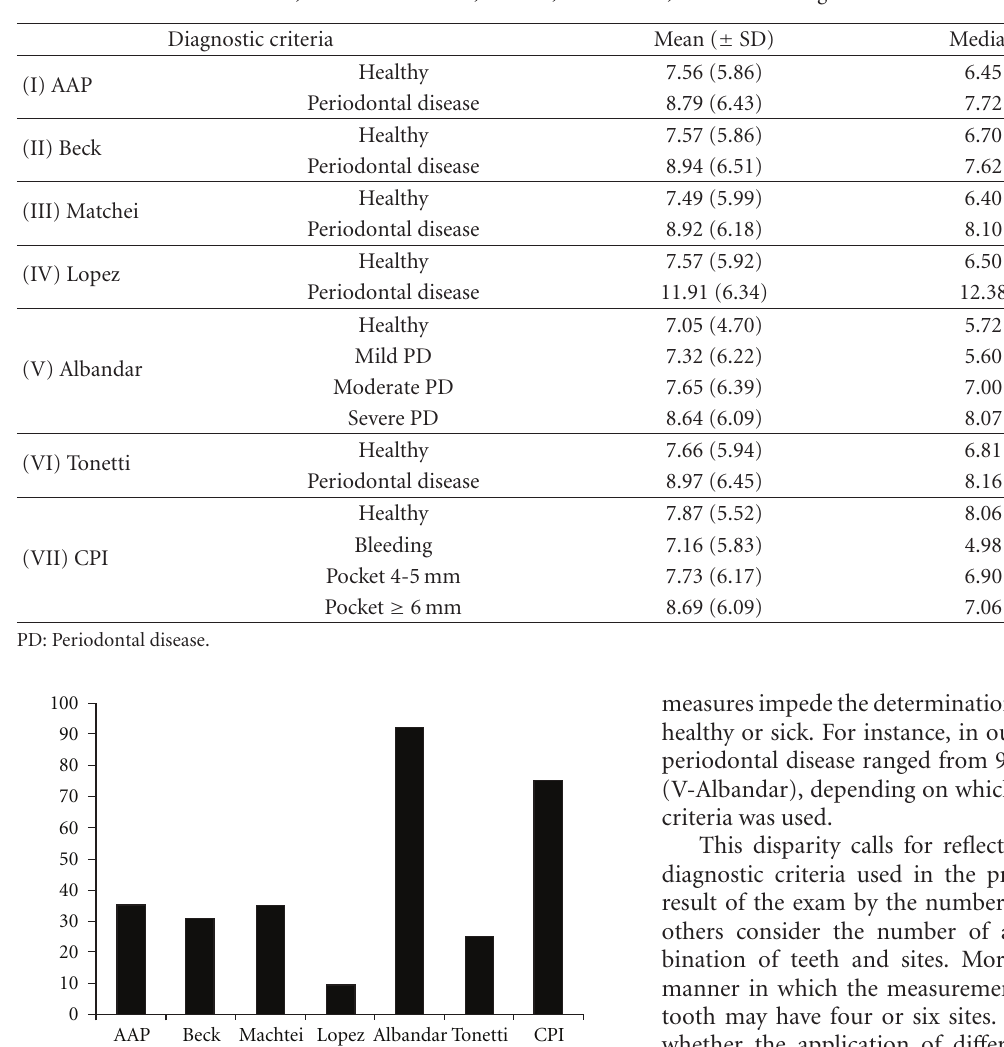
Table 3: Mean, standard deviation, median, and P value, OHIP-14 among diabetics. Belo Horizonte, 2005.